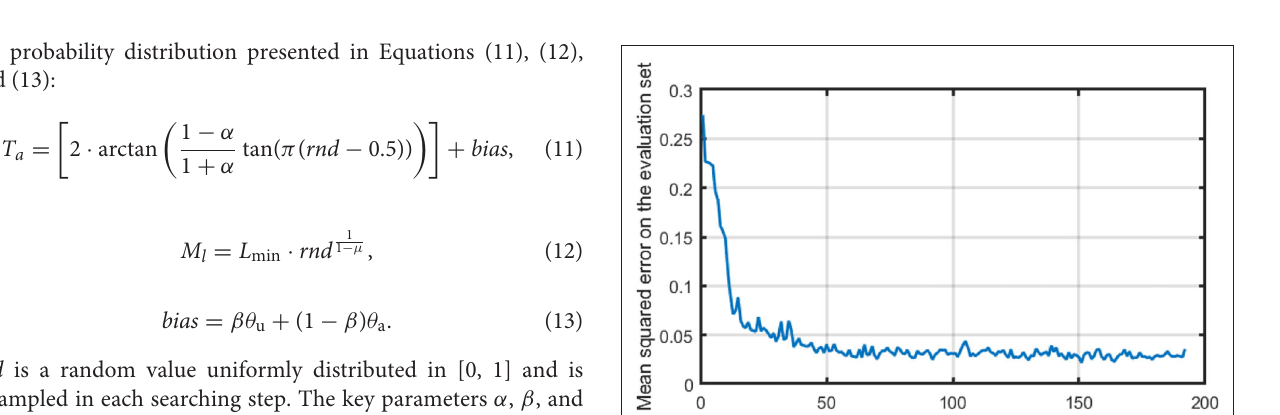
FIGURE 2 | Illustration of a snapshot of the searching area in the odor source searching problem. The odor source is represented by the star. The yellow patches represent the area within 2 m from the odor source. The wind field is illustrated by the black arrows. The red puffs are the simulated odor plumes, which resemble the real-world plumes well as shown in Figure 1 .